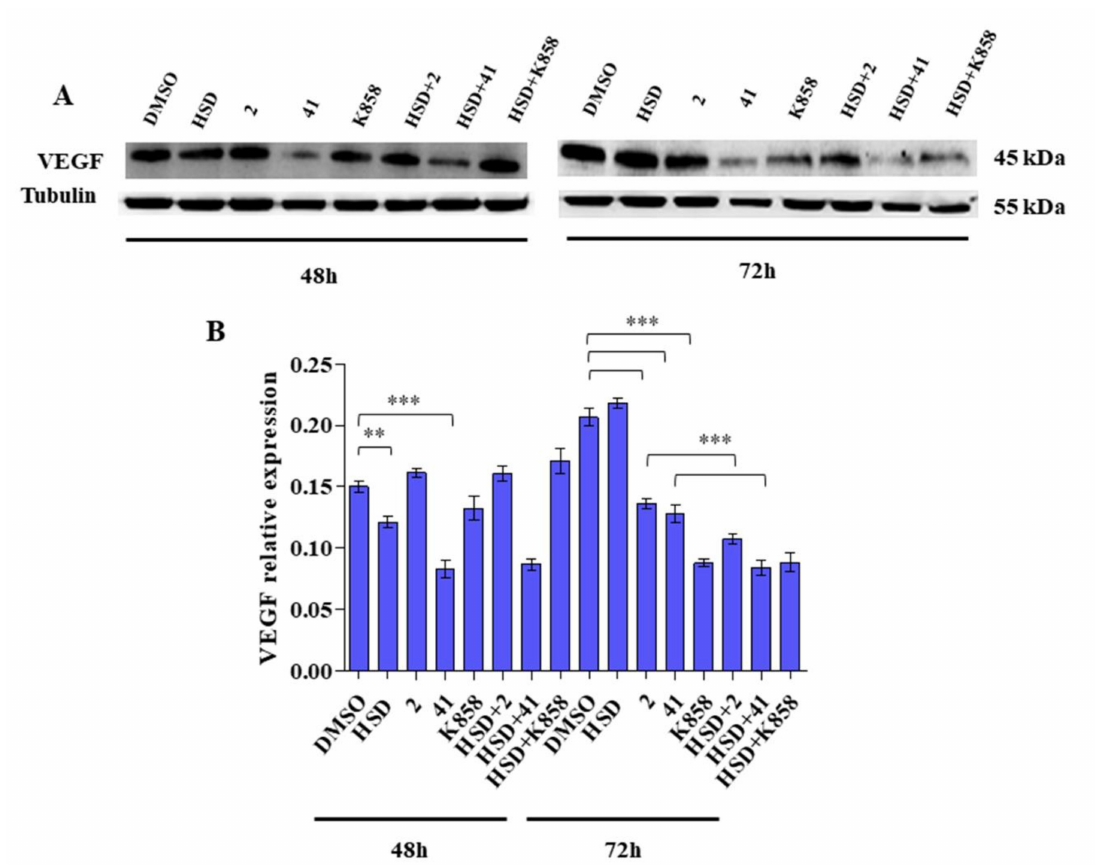
Figure 7. ( A ) VEGF expression levels in AGS cell line treated with HSD (180 µ M), 2 (1 µ M), 41 (5 µ M), K858 (1 µ M), and a combination of HSD with each Eg5 inhibitor for 48 and 72 h. DMSO 0.5%: control vehicle. Data are reported as mean ± SD of three independent experiments. Tubulin is used as a loading control. ( B ) The bar graph displays densitometric values expressed as mean ± SD normalized on loading control. *** p < 0.0001; ** p <